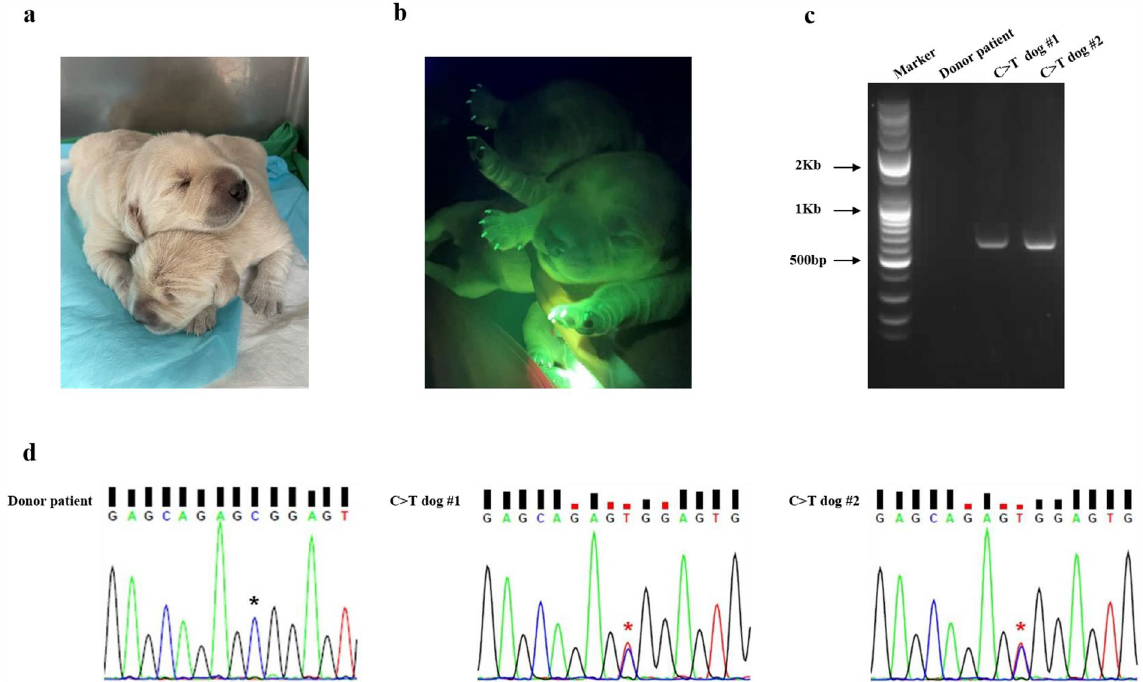
Figure 2. Generation and verification of gene-corrected dogs using somatic cell nuclear transfer (SCNT). ( a ) Bright field and ( b ) enhanced green fluorescent protein (EGFP) expression under UV light of the gene-corrected dogs. ( c ) PCR analysis of the vector construct integration in donor patient cells and gene-corrected dogs (C>T dog #1 and #2). Only the gene-corrected dogs showed a band at 600 bp. ( d ) Chromatographic analysis of target sequences from the donor patient (cells) and gene-corrected dogs. Blue star asterisks indicate SNP of donor patient and red star asterisks indicate corrected SNP sequence in C>T dogs #1 and